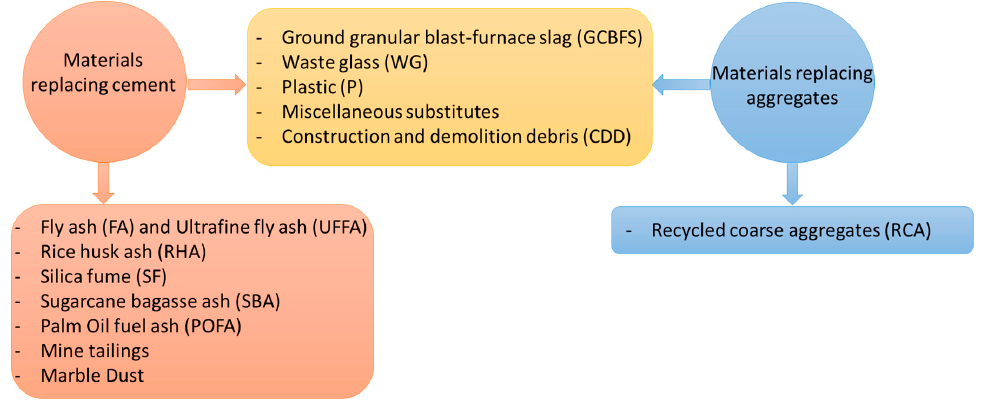
Figure 2. Most common industrial by-products used as substitutes [26] .